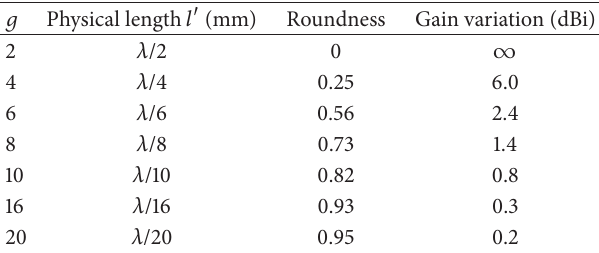
Figure 2: Geometry of a two-element array lying along the 𝑧 -axis. Table 2: Roundness and gain variation against physical length 𝑙 󸀠 .